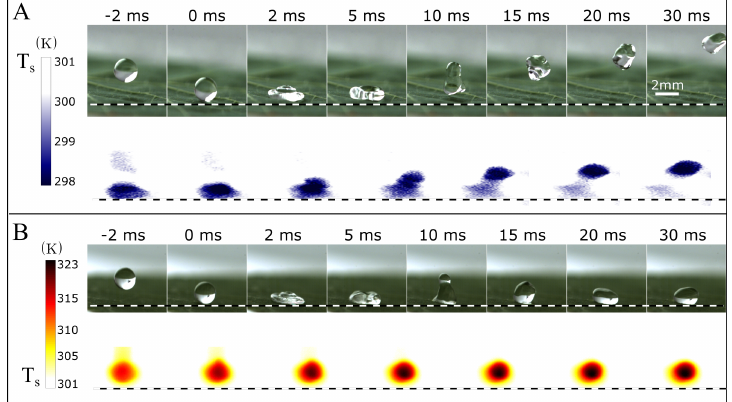
Figure 3. A superhydrophobic Nasturtium leaf that lets a cold drop bounce off of its surface traps a hot drop. ( A ) A cold water drop at temperatures 298 K impacts a Nasturtium leaf that is initially at ambient temperature 301 K. High-speed images show that the cold water drop spreads, retracts and